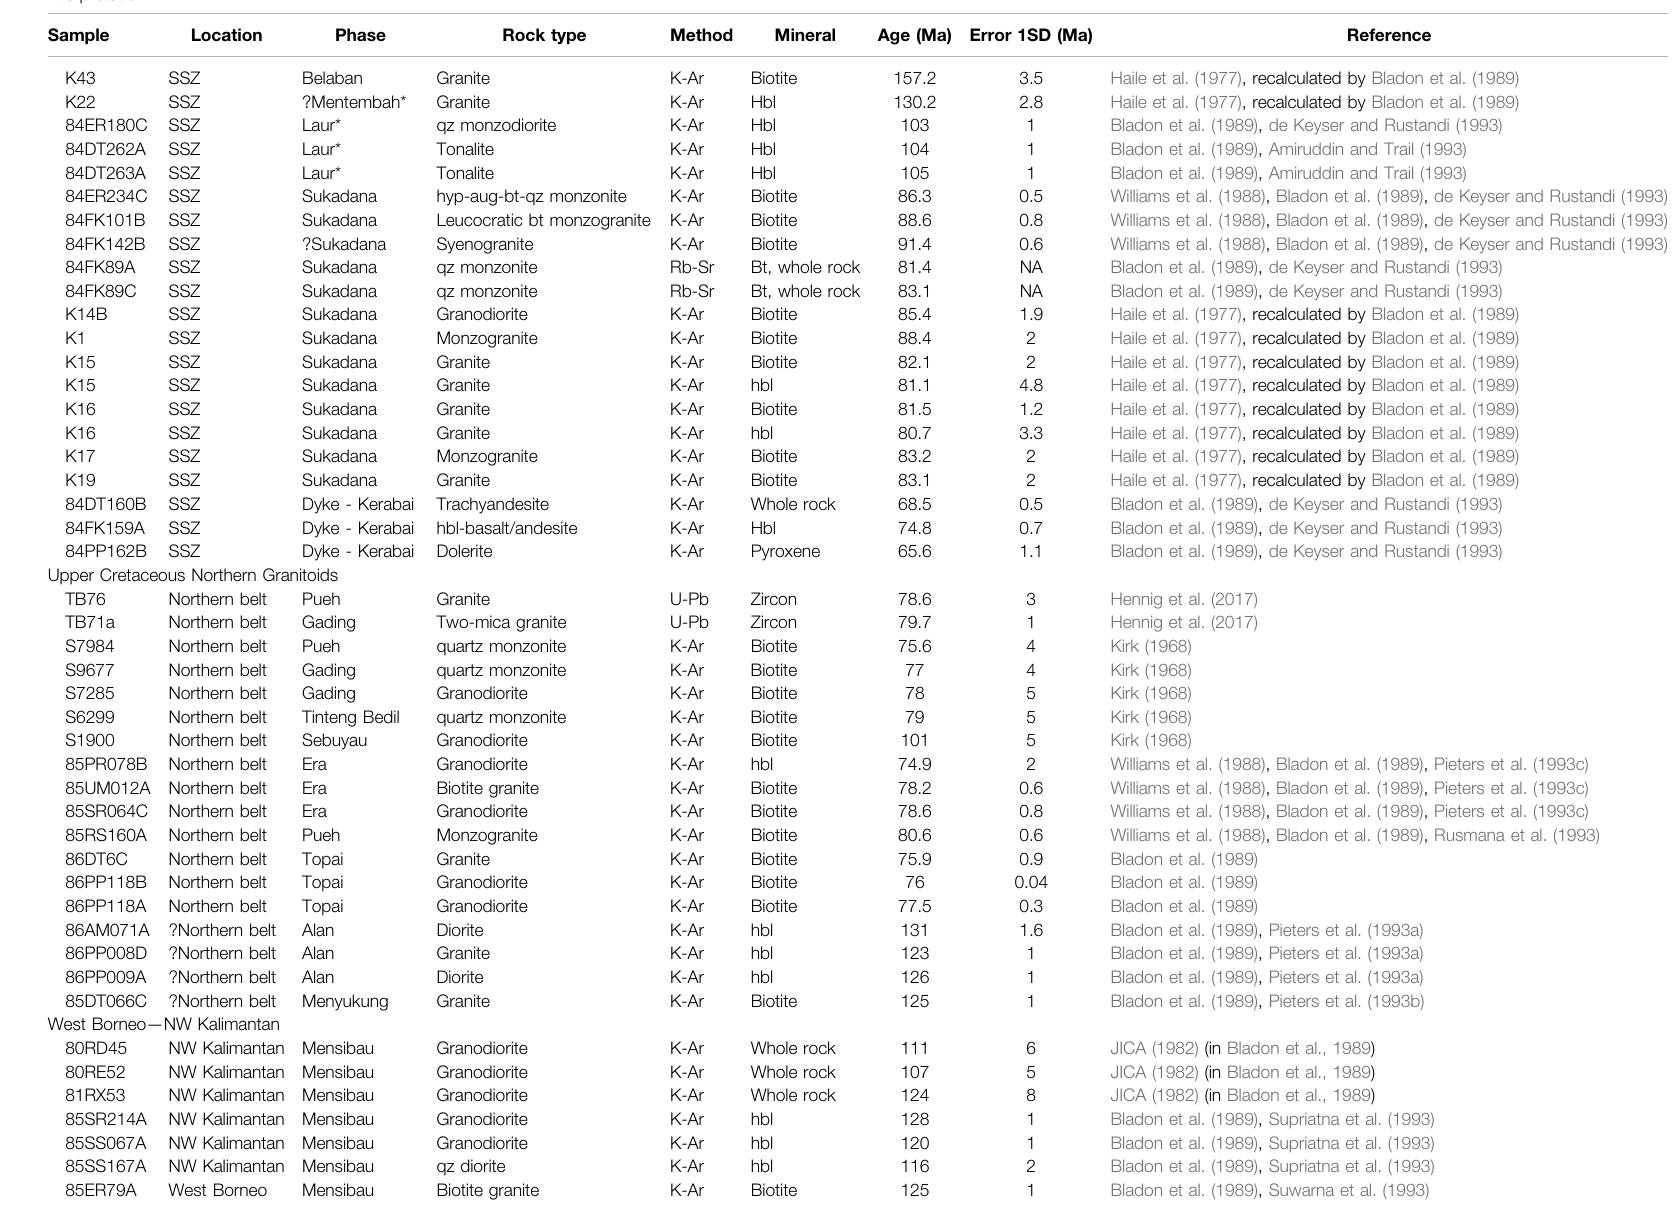
TABLE 1 | ( Continued ) Literature age data of Jurassic to Cretaceous rocks of the Schwaner Mountains and western Borneo. Phases marked with * are here reinterpreted based on their ages compared to their original